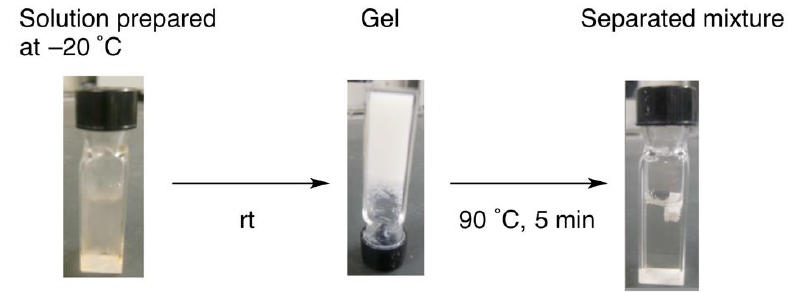
Figure 3. Photo-images of solution prepared at –20 ◦ C, gel prepared at room temperature, and separated mixture prepared by heating at 90 ◦ C of 35 wt% aqueous hydrazine containing 1.6 wt% of PNIPAM. A glass cuvette with dimensions of 45 × 12.5 × 12.5 mm was used.